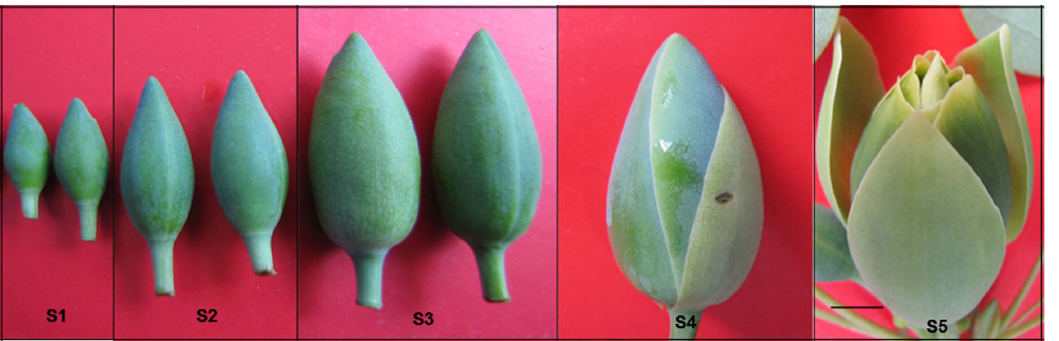
Figure 1. Different development stages of flower buds. S1: the flower buds appear on the branch; S2: ten days after S1; S3: twenty days after S1; S4: the expand period of flower buds; S5: the flower will open soon. Bar in image S5 is 1 cm, and images S1, S2, S3, and S4 have the same